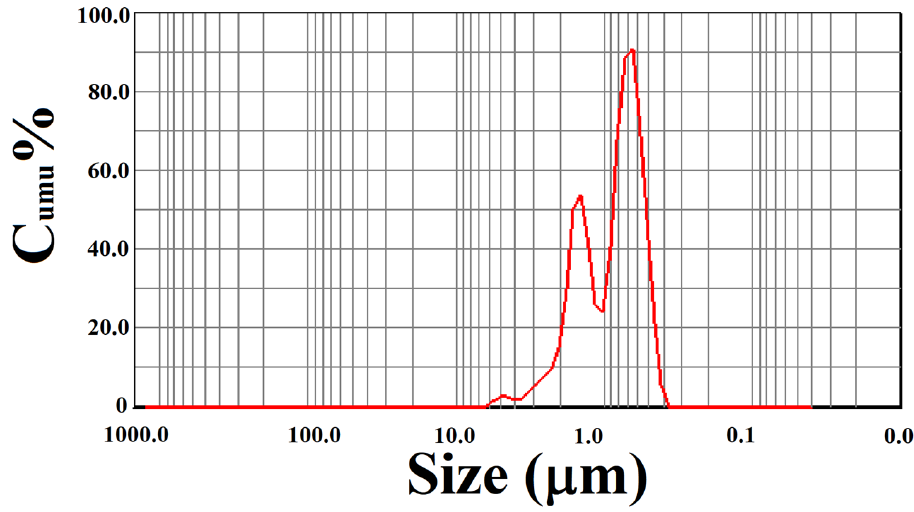
Figure 3. DLS patterns of sample (Er 3+ : 0.6 mol%).